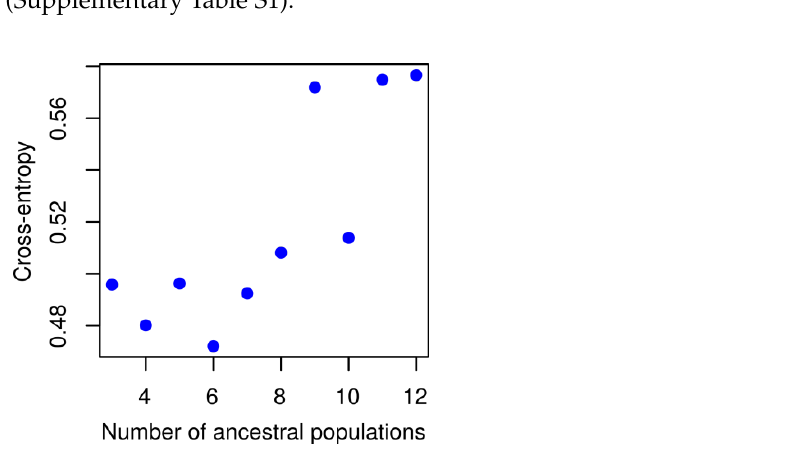
Figure 3. Cross-entropy values obtained for a given number of clusters (ancestral populations). Molecular analysis of variance (AMOVA) supported the hypothesis that such a grouping into subpopulations is not random (simulated p -value: 9.999 × 10 −5 ). Membership of all genotypes to six subpopulations were visualized by the ancestry matrix (Figure 4).